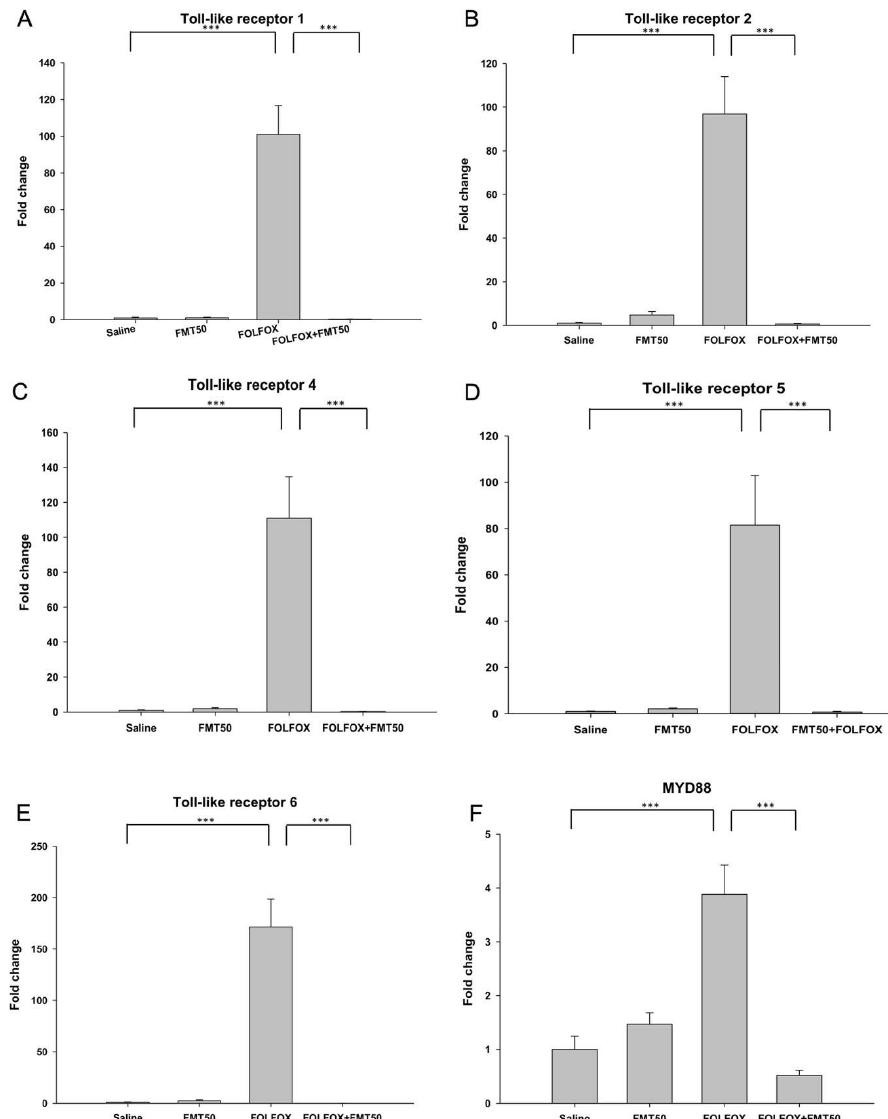
Figure 5. mRNA expression levels of toll-like receptors (TLRs) and MyD88 in the jejunum of subcutaneously injected colorectal cancer mice exhibiting FOLFOX-induced intestinal damage with / without FMT ( n = 6 for each group). Relative mRNA expression levels of ( A ) TLR1, ( B ) TLR2, ( C ) TLR3, ( D ) TLR4, ( E ) TLR5, and ( F ) MyD88 were determined by qPCR in jejunum tissues. FMT50: 50 mg / mL. Values are presented as the mean ± SEM. ***: p < 0.001.